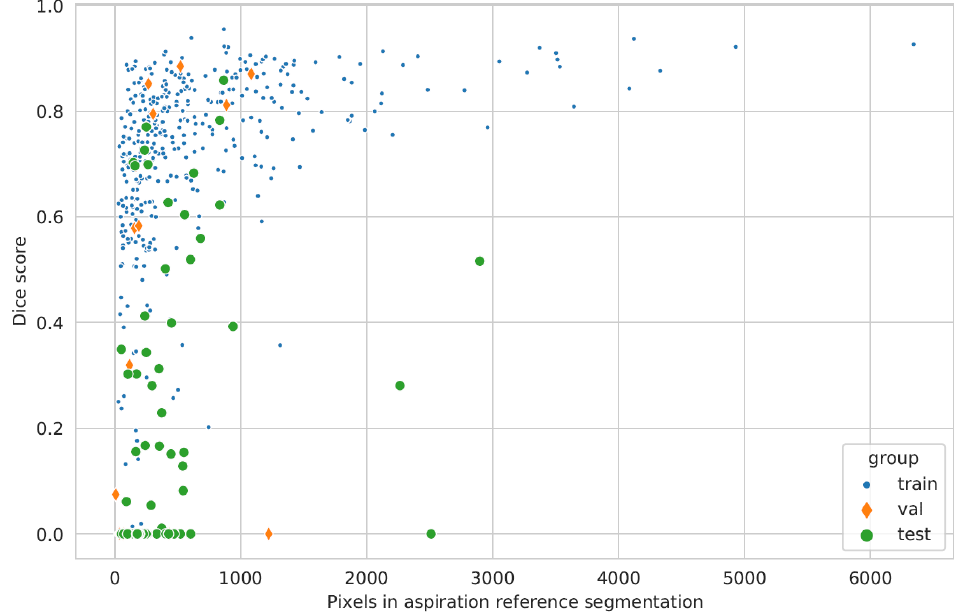
Figure 6. Scatterplot of the overlap between the number of pixels for the aspiration in the reference annotation (x-axis) and the Dice score for the overlap of AI detection (y-axis) and reference during training, validation, and testing.